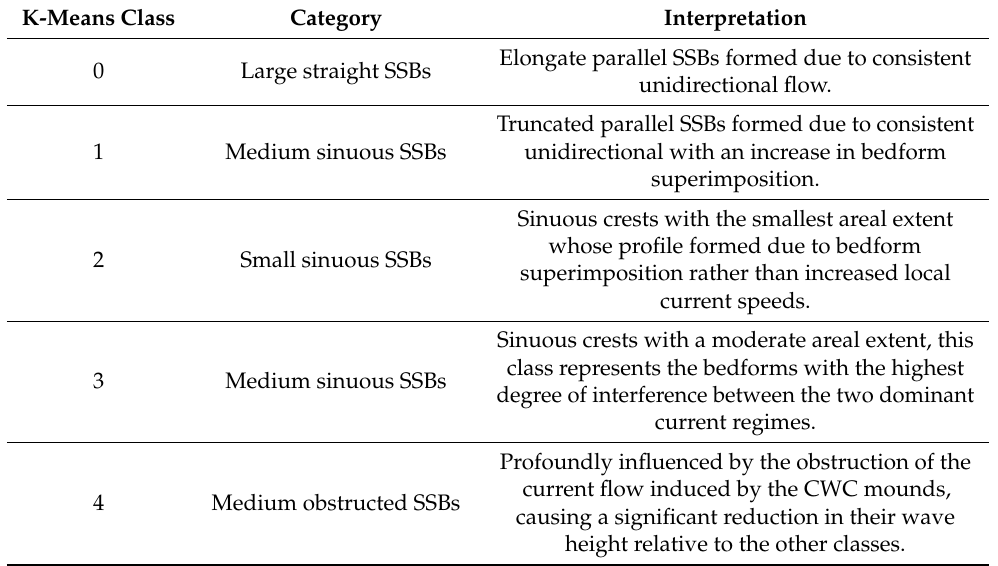
Table 4. Reconciliation of k-means classes to environmental categories complete with a brief